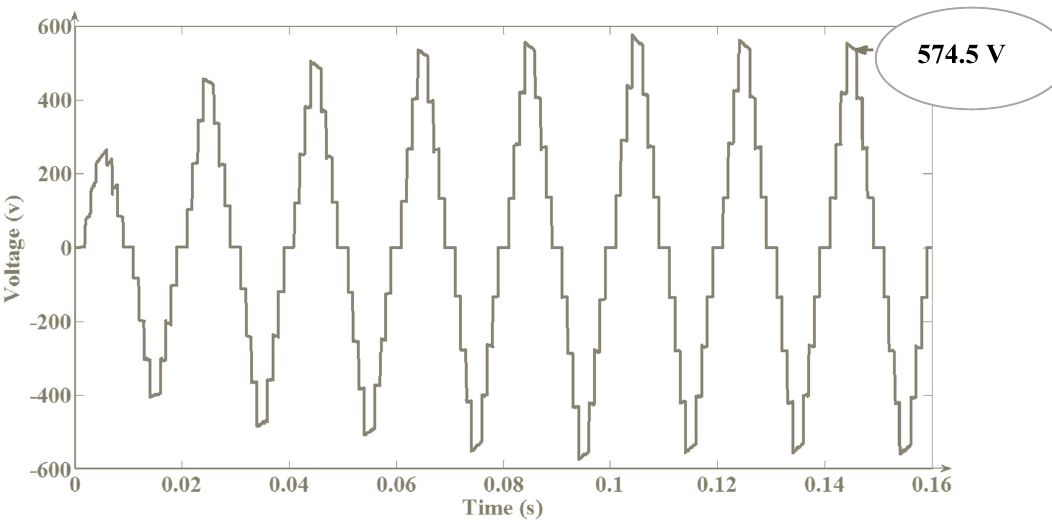
Figure 48. Stepped voltage waveform for MLI interfaced with hybrid controller-2-based BDC.